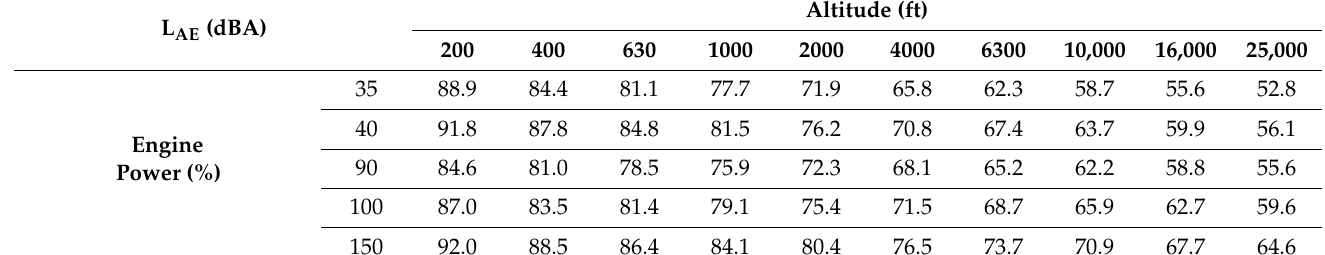
Table 1. Example of NPD data.